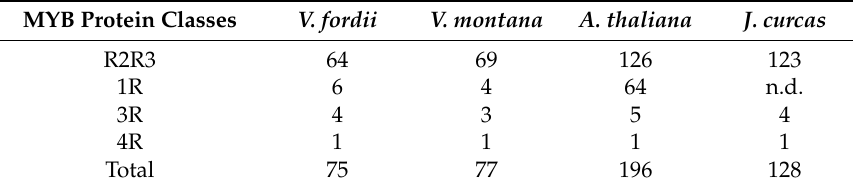
Table 1. Numbers of the MYB family in V. montana , V. fordii , Arabidopsis thaliana and Jatropha curcas . MYB Protein